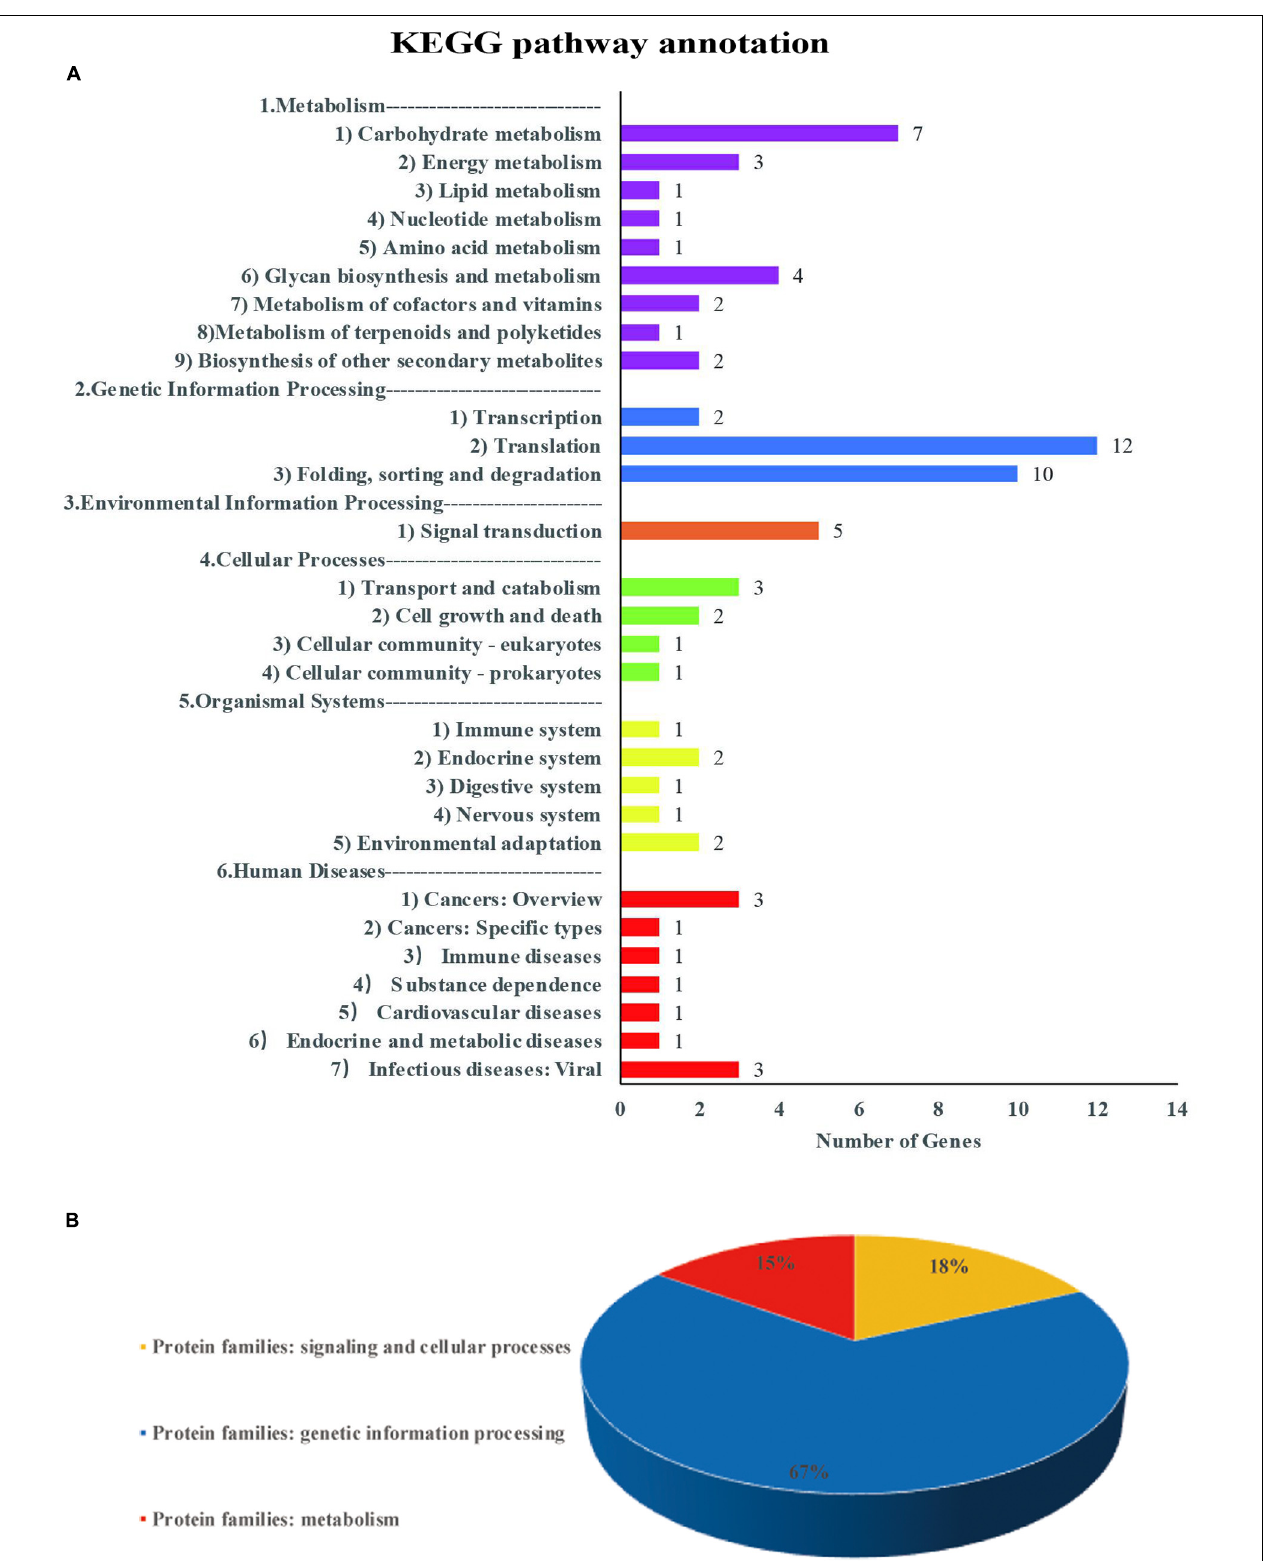
FIGURE 7 | Information on pathways and orthologous protein families of 51 genes. Panel (A) shows the information on pathway. Panel (B) shows the information on orthologous protein families.